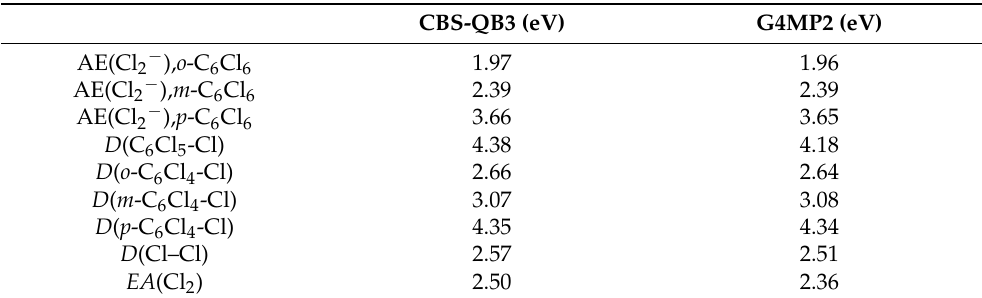
Table 1. Calculated Cl 2 − appearance energies (AE), bond dissociation energies (D) and electron affinity (EA) for hexachlorobenzene at different levels of theory. Values are in